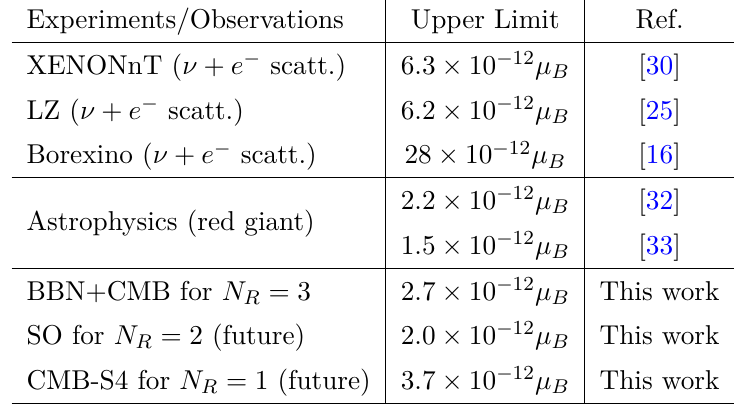
Table 2 . Severe bounds of µ ν at O (10 − 12 µ B ) from recent terrestrial, astrophysical and cosmological